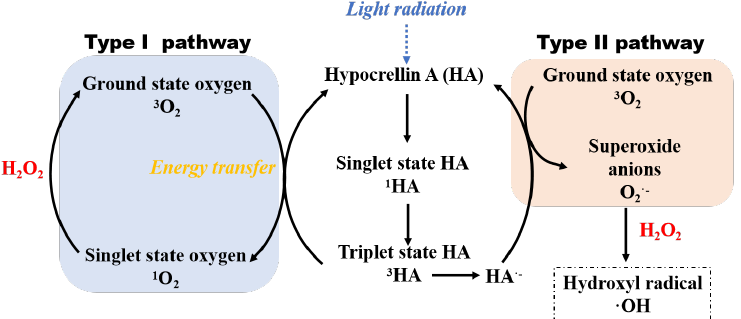
Figure 5. The mechanism of promotion on the generation of hydroxyl radicals in the HYPs/H 2 O 2 PAOP using the example of the HA. Table 2. The performance of the PAOP system proposed in the work and previous